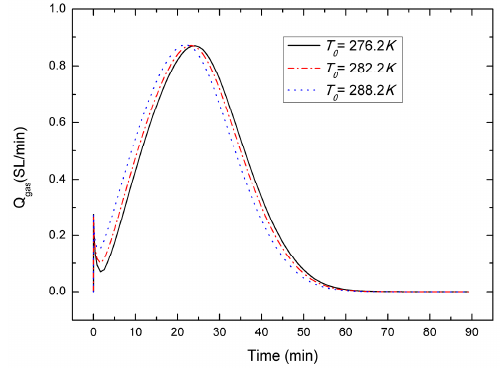
Figure 10. Gas generation rate with varying initial temperature